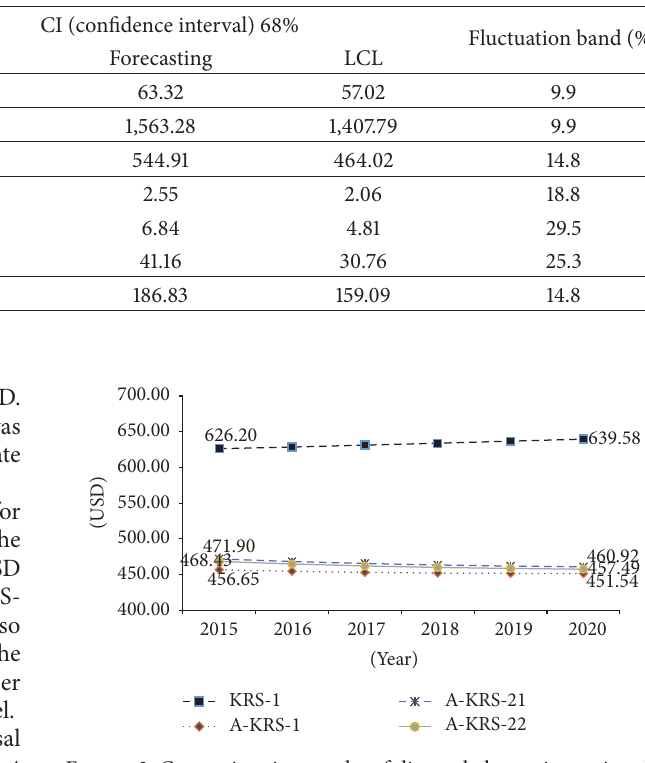
Figure 3: Cost estimation results of disposal alternatives using the ARIMA